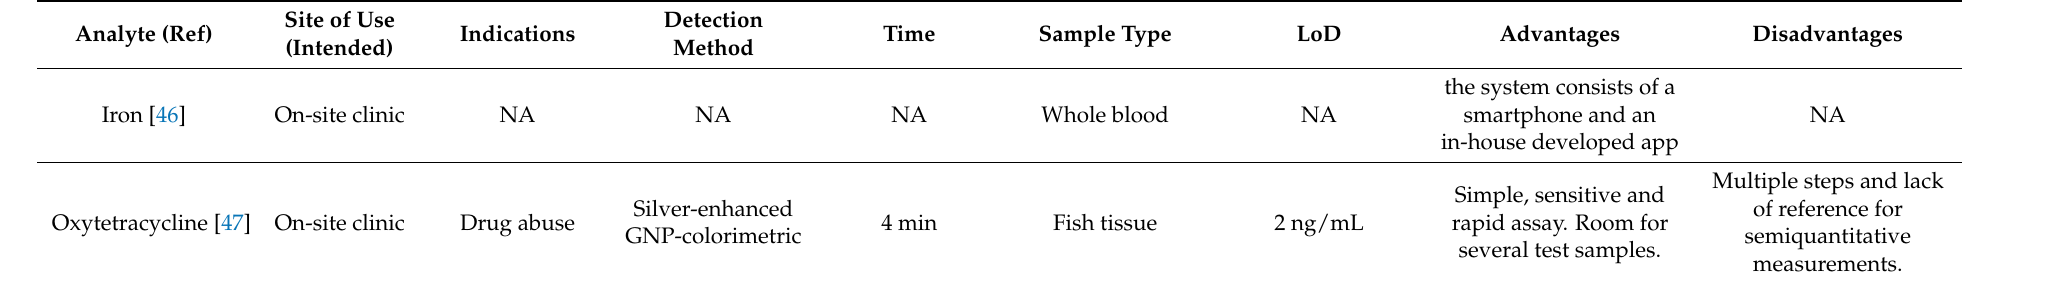
Table 5. Vertical flow assay for small molecules